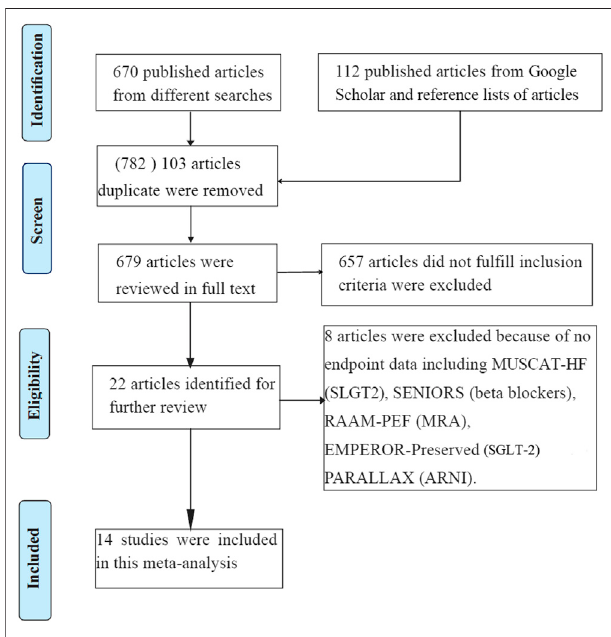
FIGURE 5 | Risk of bias of all